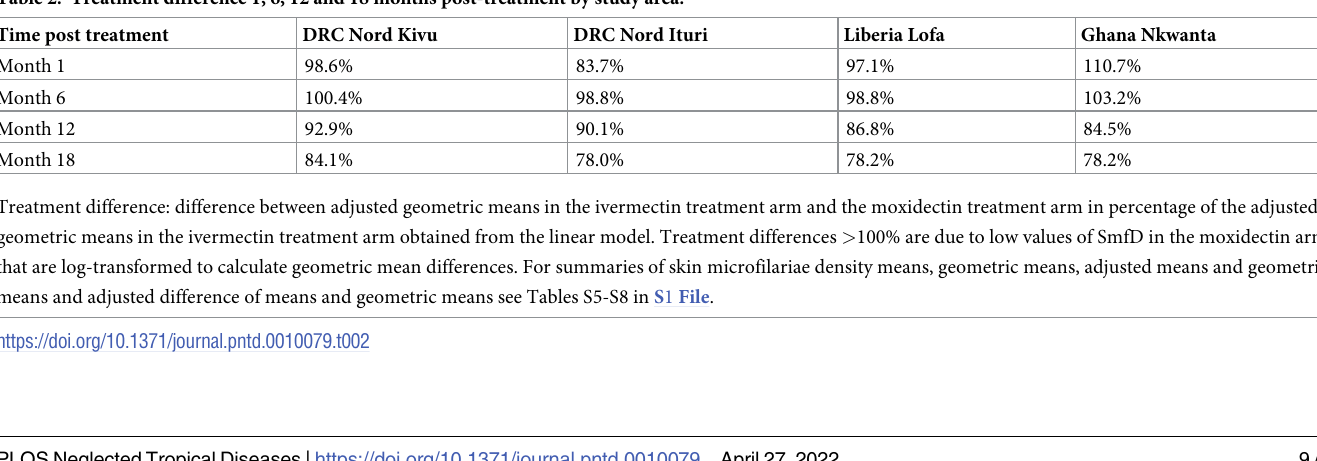
Table 2. Treatment difference 1, 6, 12 and 18 months post-treatment by study area.